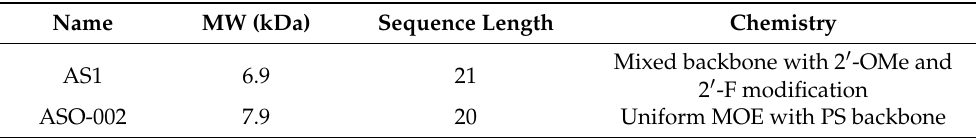
Table 5. siRNA-01 antisense strand, AS1, and its internal standard, ASO-002.